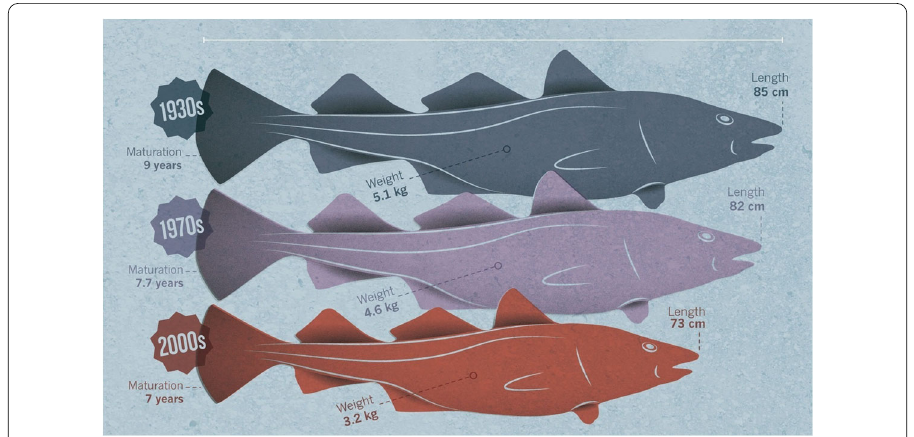
Figure 1 Northeast Arctic cod body sizes have declined